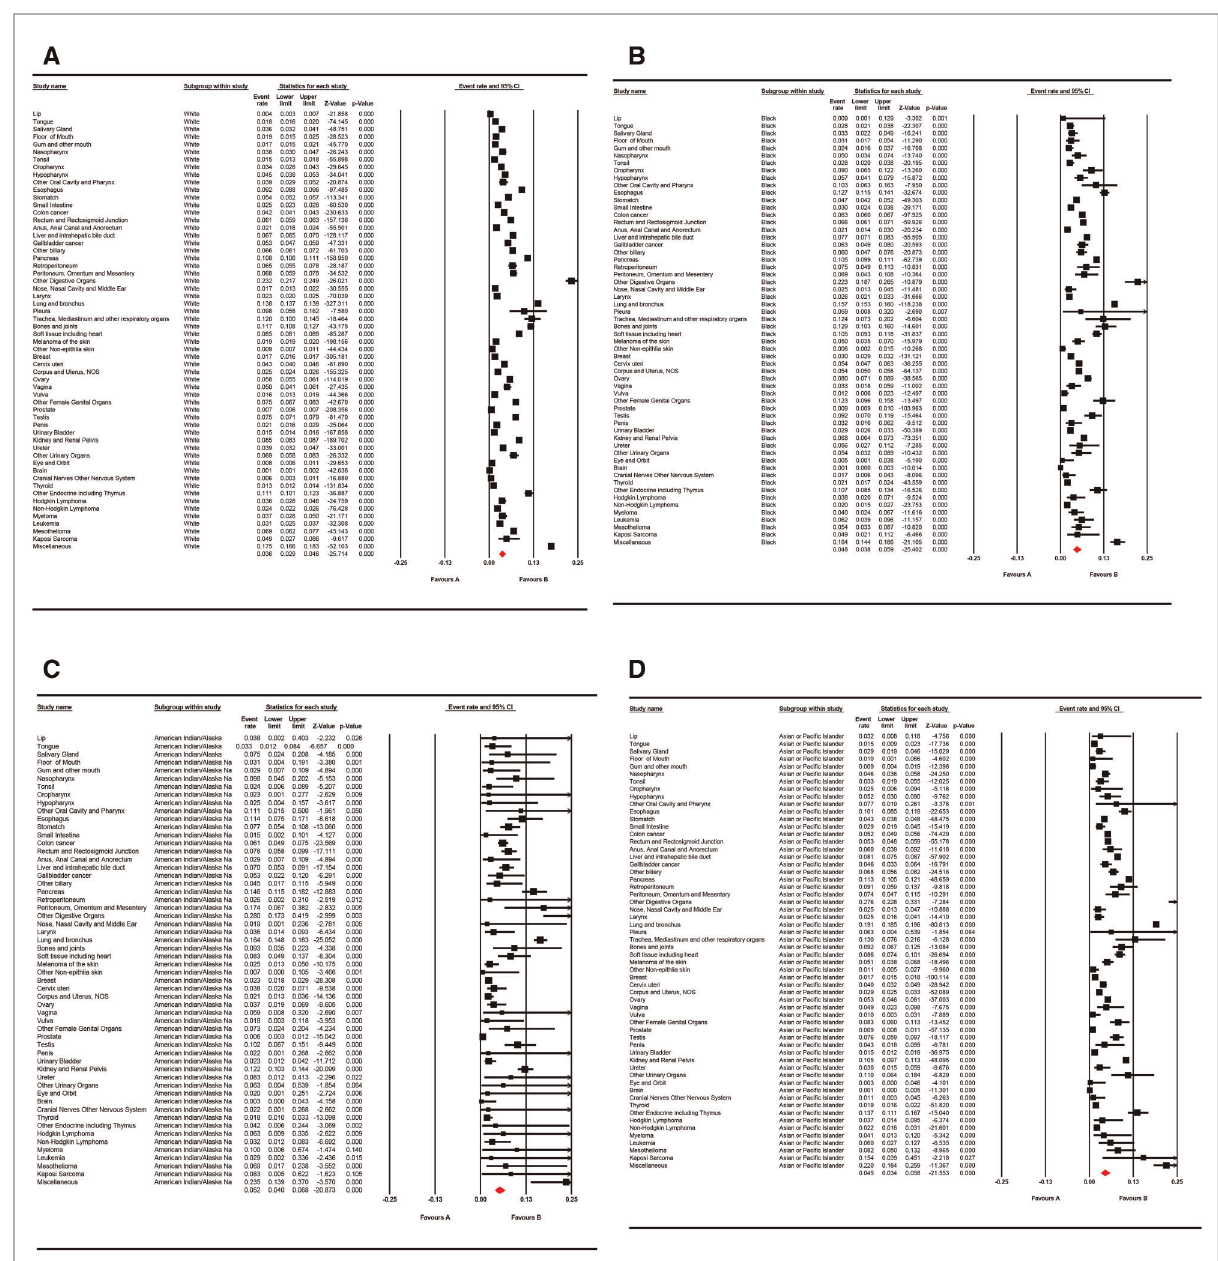
FIGURE 3 Forest plot for the pooled prevalence of lung metastases for different cancer sites in ( A ) “ white, ” ( B ) “ black, ” ( C ) American Indian/Alaska Native population, and ( D ) Asian or Paci fi c Islander populations with random effects